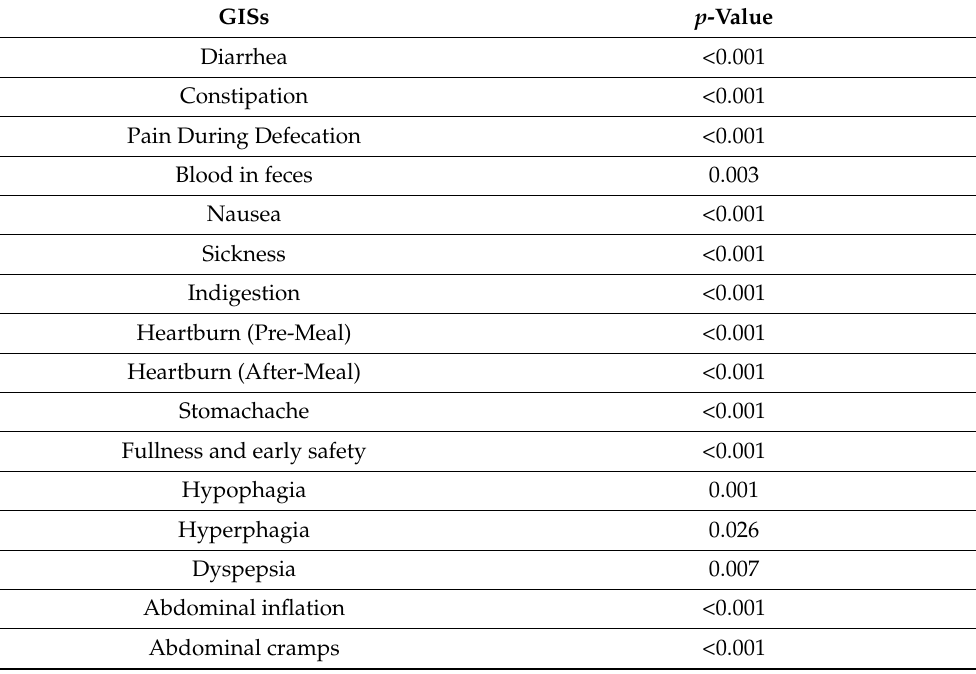
Table 6. Correlation between GISs before and during the SARS-CoV-2 lockdown.